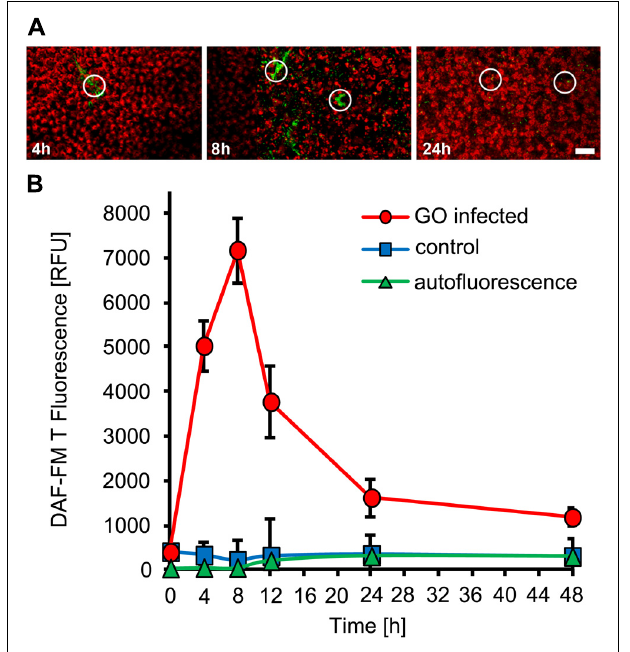
FIGURE 1 | NO accumulation in Arabidopsis leaves upon inoculation with the adapted powdery mildew fungus, Golovinomyces orontii . Leaves of Arabidopsis thaliana Col-0 were harvested at the indicated times after inoculation and used to detect intracellular NO by infiltration of the NO sensitive dye DAF-FM DA. (A) Time series of confocal images (taken at 4, 8, and 24 h post-inoculation) showing focused NO accumulation, as indicated by the green fluorescence, at the powdery mildew infection sites (white circles).The red color is due to chlorophyll fluorescence. (B) Time course of NO accumulation at fungal infection sites (red circles) and corresponding areas of non-infected control leaves (blue squares). NO was quantified by integrating the pixel intensity of green DAF-FMT fluorescence in three-dimensional optical reconstructions of infections sites (area defined by circles). Autofluorescence at infection sites was quantified without prior staining with DAF-FM DA (green triangles). Each data point reflects the mean ( ± SD) of 20 infection sites taken from four different leaves of two different plants. Bar = 50 μ